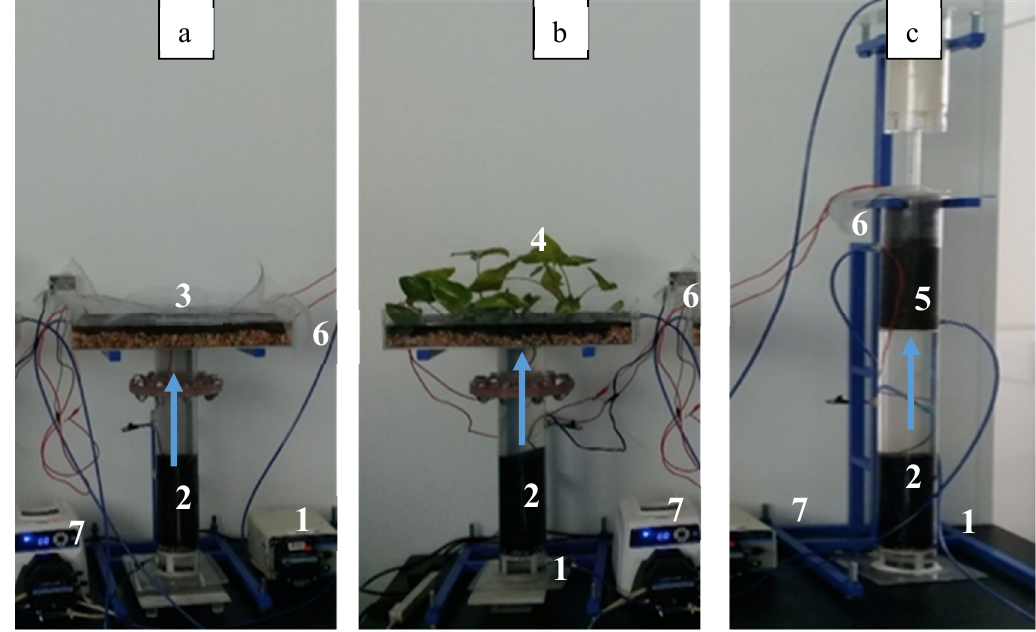
Figure 6. Experimental arrangement of the 3 up-flow MFCs under study ( a ) MFCE, ( b ) MFCW and ( c ) MFCT. (1) Wastewater influent (2) GAC anodes, (3) GAC cathode, (4) GAC cathode-wetland, (5)